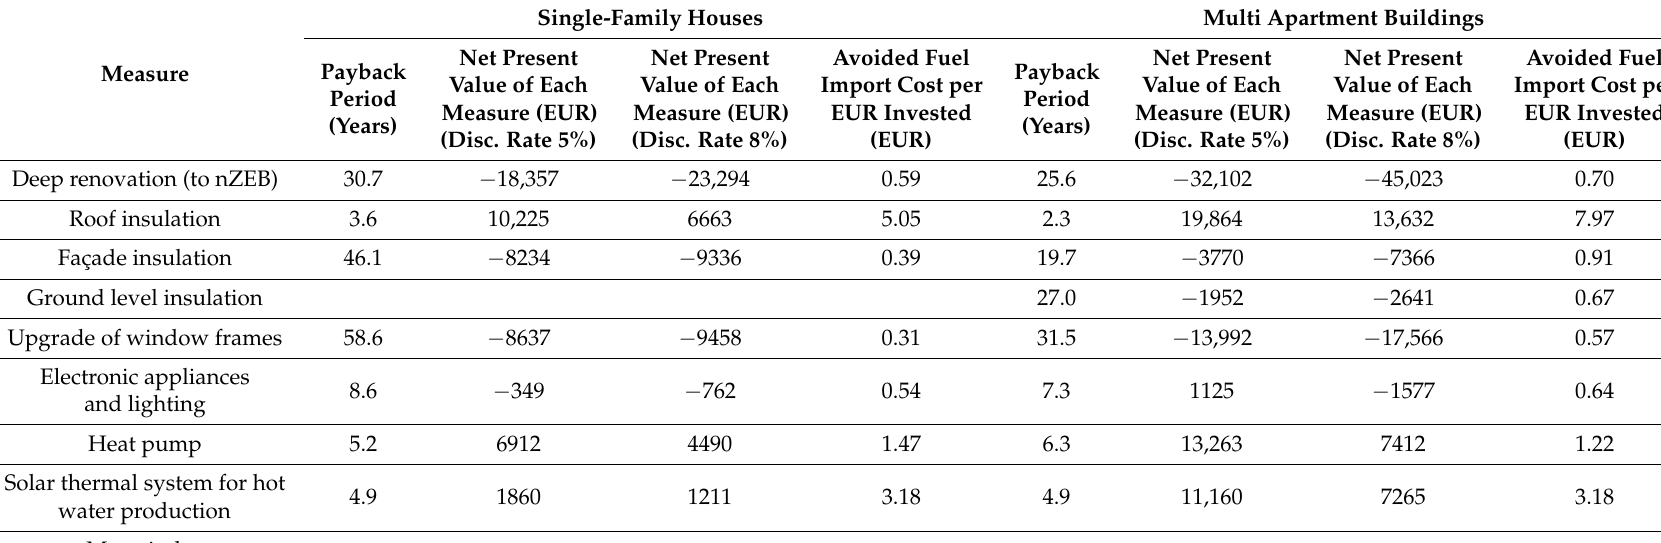
Table 7. Mean values of cost-effectiveness indices of energy efficiency measures in the two main types of residential buildings of Cyprus.